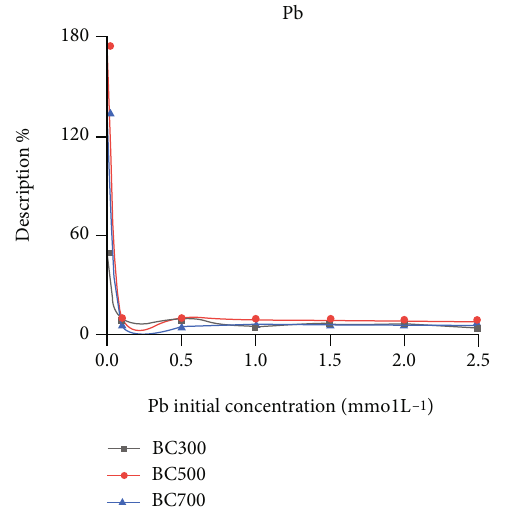
Figure 4: Desorption rate of Pb 2+ in straw with di ff erent concentrations of heavy metal ions.